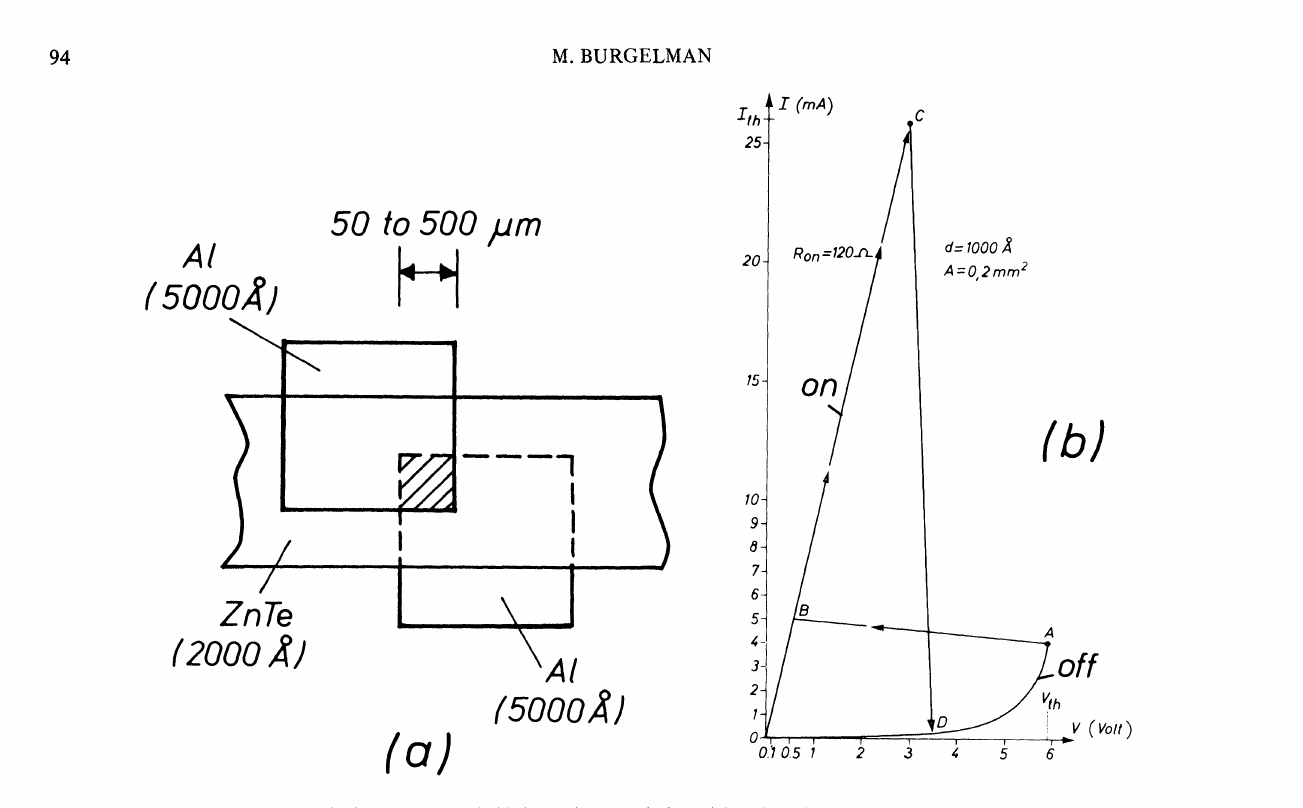
FIGURE (a) Typical structure and (b) I-V characteristics with off- and on-state of a ZnTe memory device.